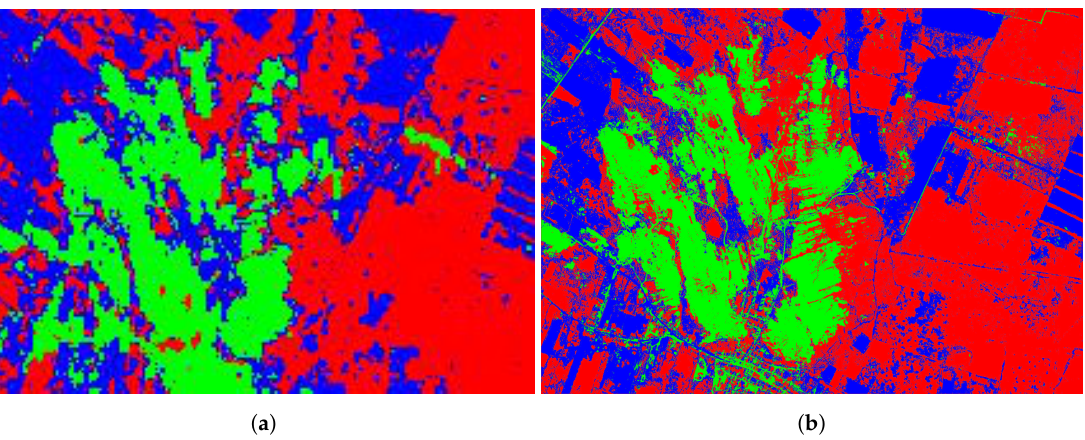
Figure 18. Classified RGB compositions. The areas in green are exposed soil (outcrop), the areas in red are grassland, and the areas in blue are dense vegetation or forest. ( a ) Classified Landsat 8 NIR and SWIR bands composition with 15m pixel resolution. ( b ) Classified predicted NIR and SWIR bands composition with pixel size of 1m approximately.